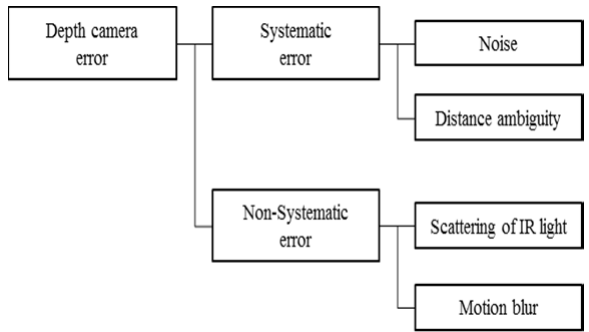
Figure 1. Errors of depth camera image